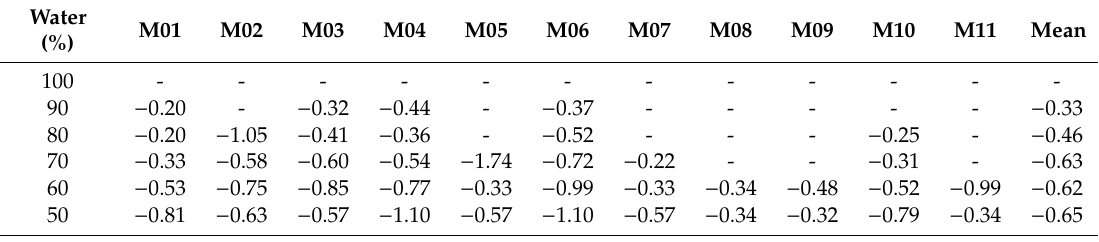
Table 4. Water price-elasticity demand in the irrigation modules of the Irrigation District